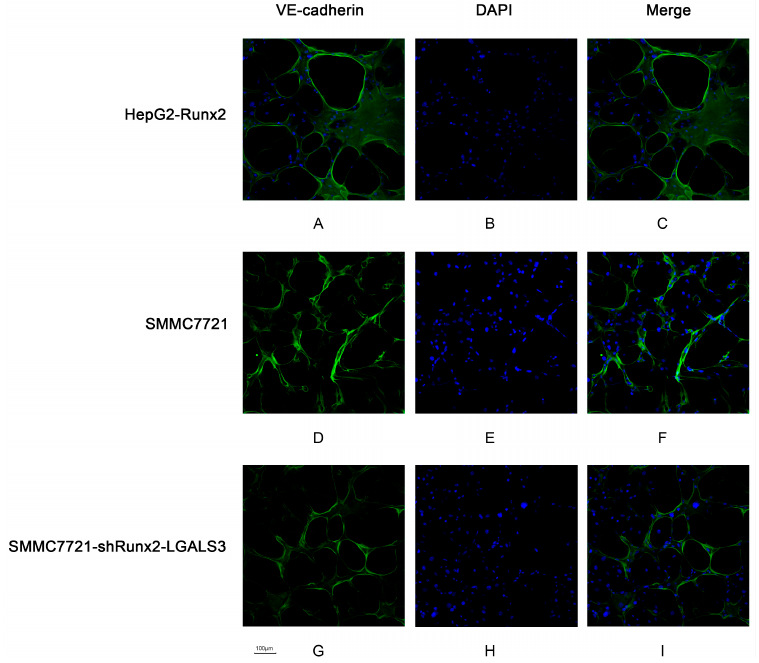
Figure 6. The VM-like tubes formed by HepG2-Runx2 cells, SMMC7721 cells and SMMC7721- shRunx2-LGALS3 cells were assessed by VE-cadherin immunofluorescence and confocal microscopy ( × 200). ( A , D , G ) VE-cadherin staining of the VM channel was concentrated in the wall of the tubes; ( B , E , H ) The cell nuclei were stained by DAPI; ( C , F , I ) The merged images showed that the expression of VE-cadherin in VM